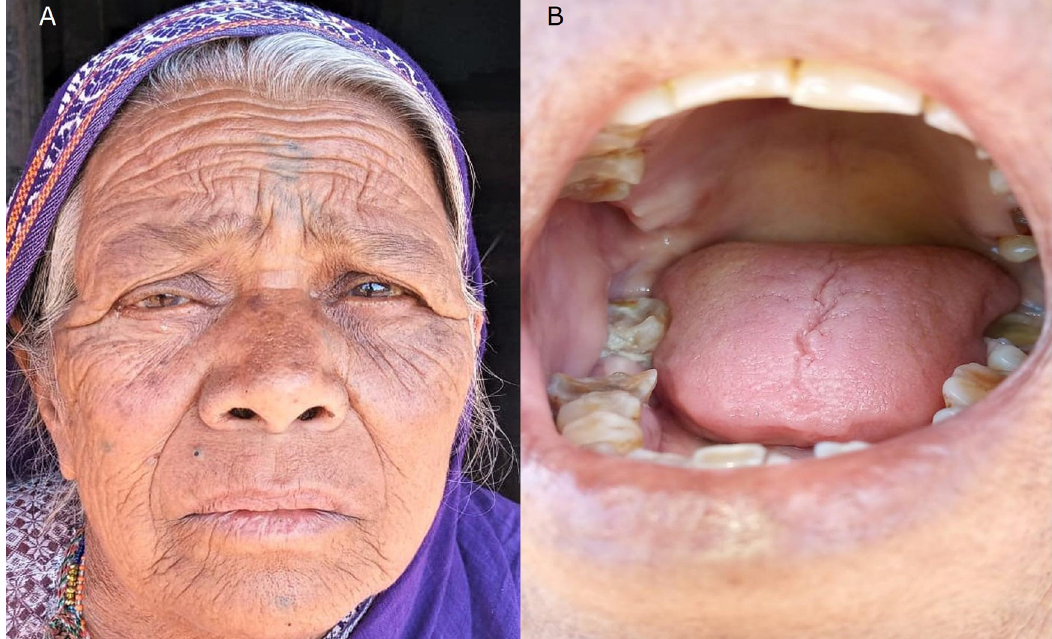
Fig. 5. Complete recovery after 1 month with no residual effect (A), Mouth opening in normal limit with complete healing at extraction site